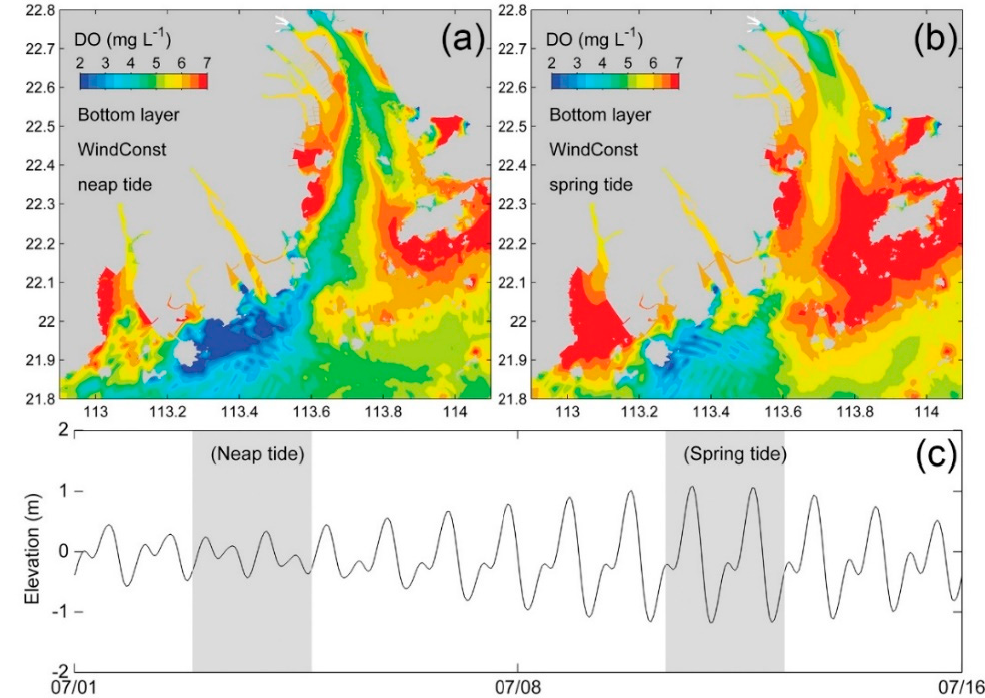
Figure 15. Bottom DO concentration during ( a ) neap tide and ( b ) spring tide in the WindConst case. ( c ) Water elevation during a tidal cycle in the Modaomen hypoxic zone.